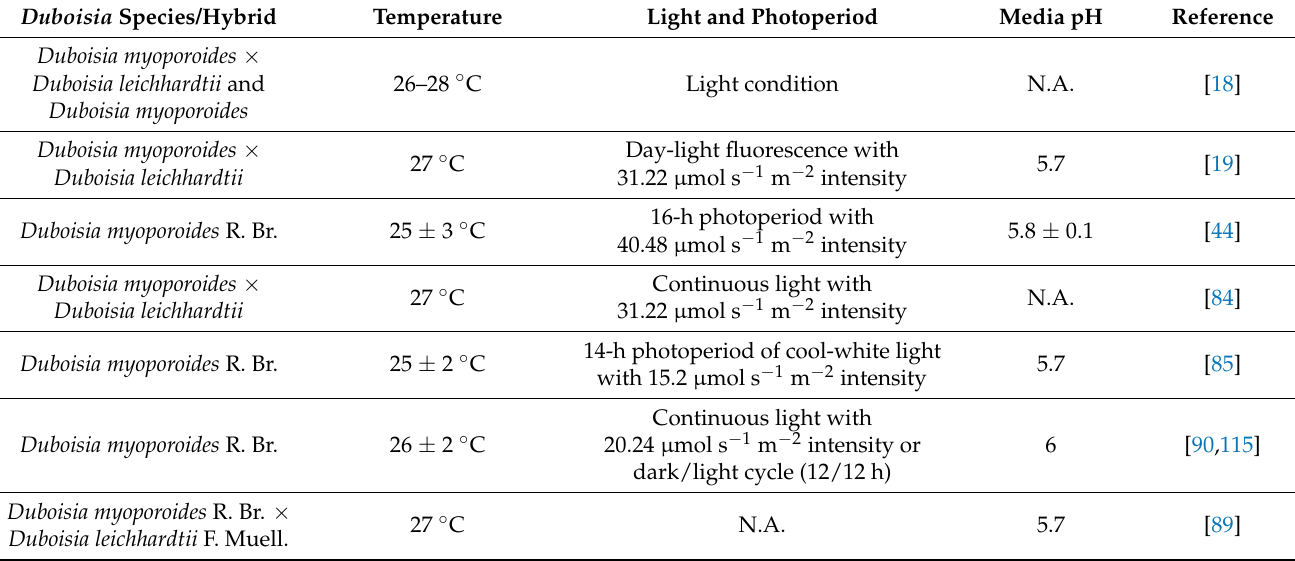
Table 5. Summary of external incubation conditions for Duboisia in vitro regeneration.